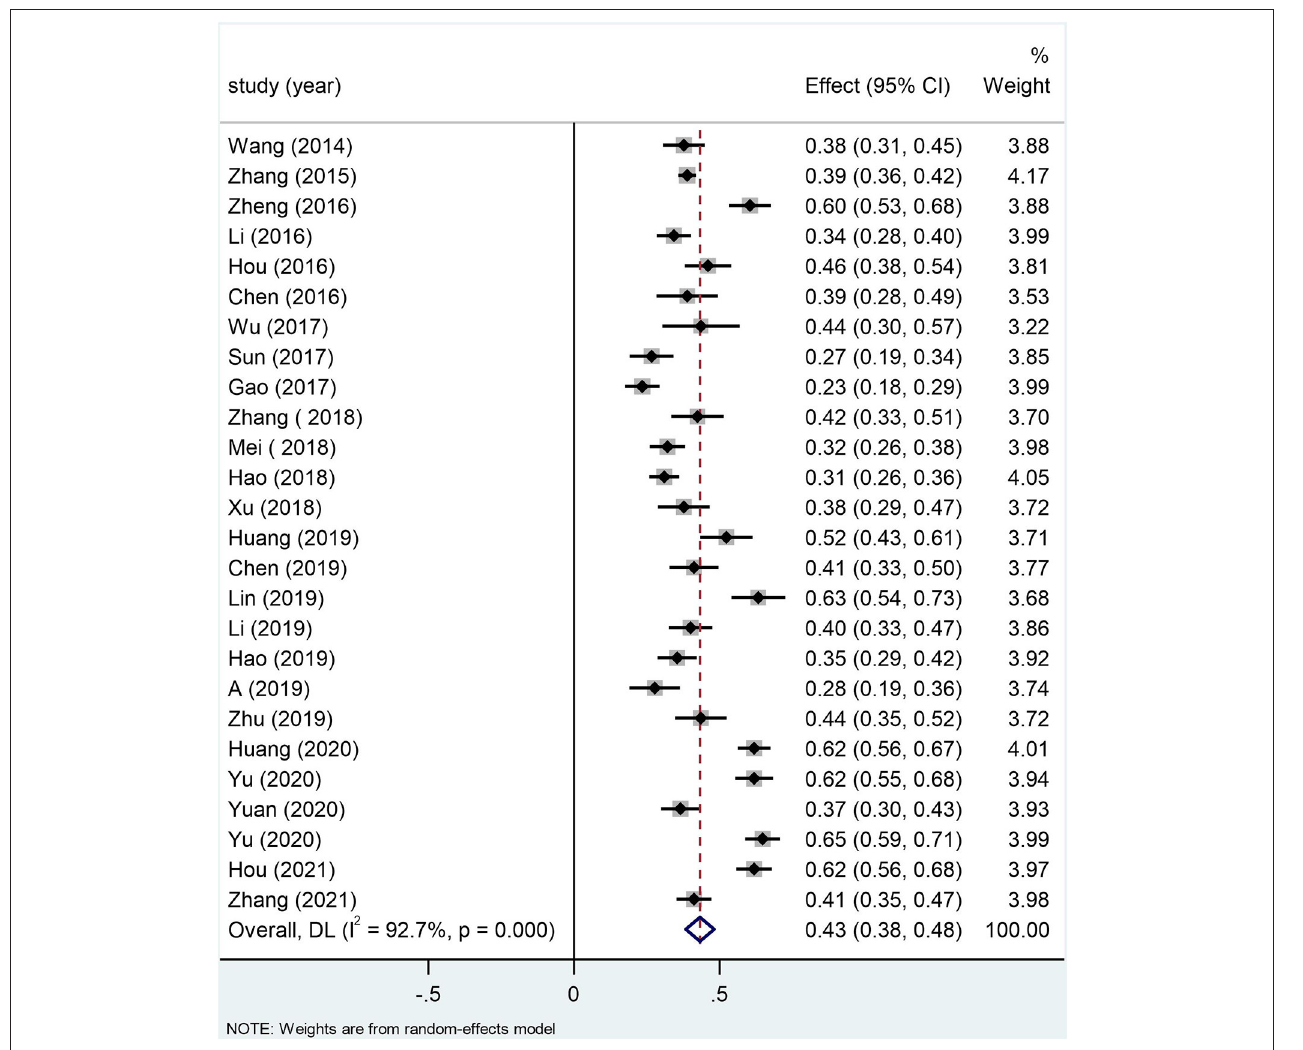
FIGURE 2 | Forest plots for the correlation between alexithymia and mobile phone